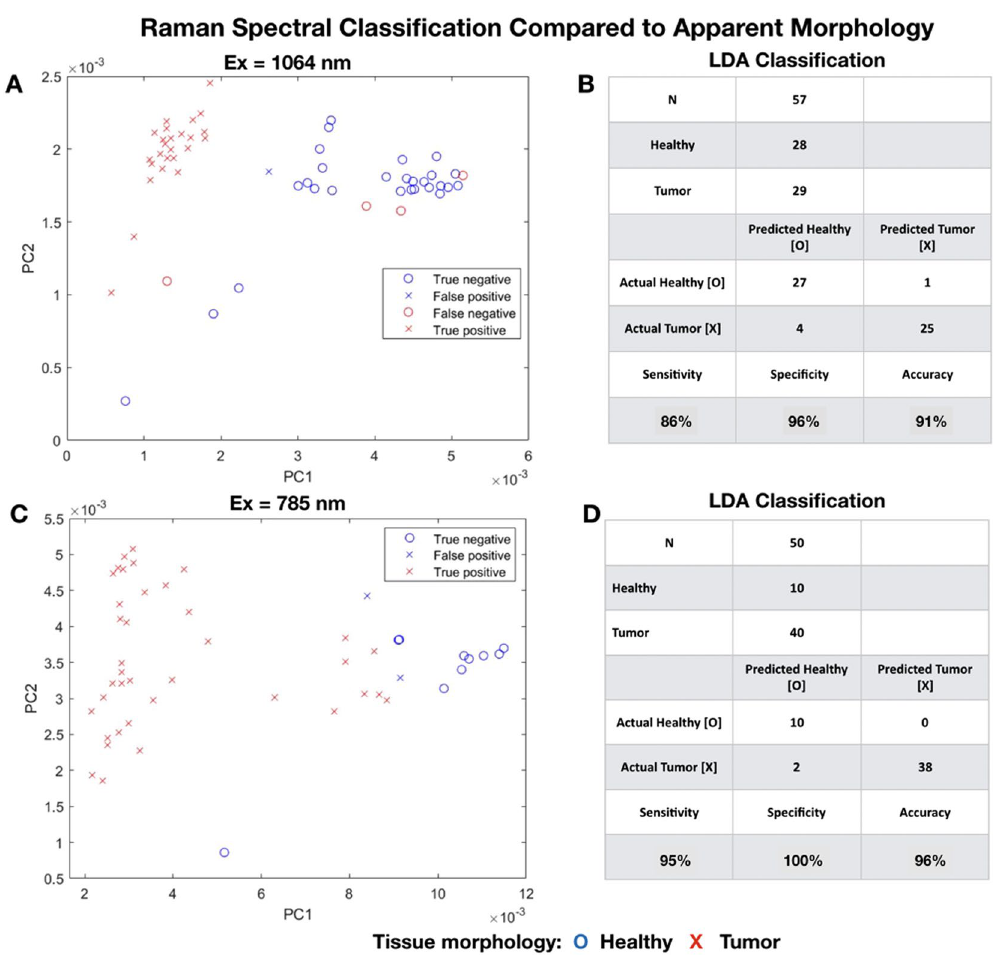
Figure 3. PCA-LDA classification of Raman spectra generated by 1064 nm and 785 nm systems. Figure 3 depicts the PCA-LDA identification of two spectral classes for tissue regions that by visual morphological classification were either tumor-rich ( ) or healthy ( ). We utilized the 3 PCA factors (Table 3) extracted from the 1064 nm and 785 nm data as inputs for LDA classification. Figure 3A is a plot of PC1 and PC2 factors extracted from 1064 nm spectral data from 57 targets in tissue regions that appeared either macroscopically healthy (N = 28) or tumor-rich (N = 29). LDA (Fig. 3B) classifies 27 of the 28 spectra from healthy regions as healthy, and 25 of 29 spectra from tumor-rich regions as pathological (sensitivity = 86%, specificity = 96%, and accuracy = 91%). Figure 3C is a plot of PC1 and PC2 factors extracted from 785 nm data from 50 targets in tissue regions that appeared either macroscopically healthy (N = 10) or tumor-rich (N = 40). LDA (Fig. 3D) classifies 10 of the 10 spectra from healthy regions as healthy, and 38 of 40 spectra from tumor-rich regions as pathological (sensitivity = 95%, specificity = 100%, and accuracy =